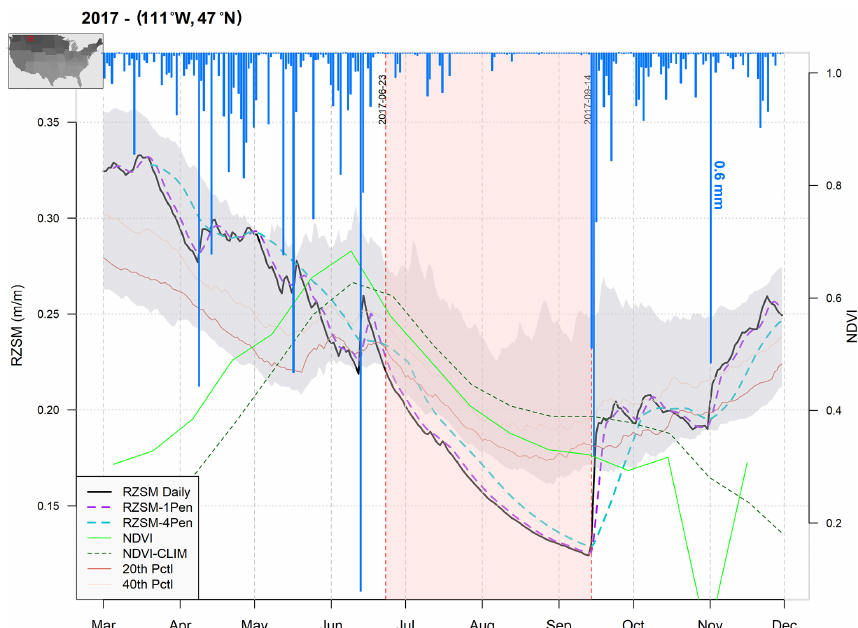
Figure 2. SMVI proposed definition as applied to a grid point within the state of Montana in 2017. Shaded red region represents the flash drought event. Gray shading represents the 10th to 90th percentile climatology of daily RZSM. Vertical blue bars are the region’s averaged daily precipitation. Vegetation deterioration is evident during the defined flash drought event as NDVI (solid green line) drops below the climatological NDVI (dashed green line) acquired from